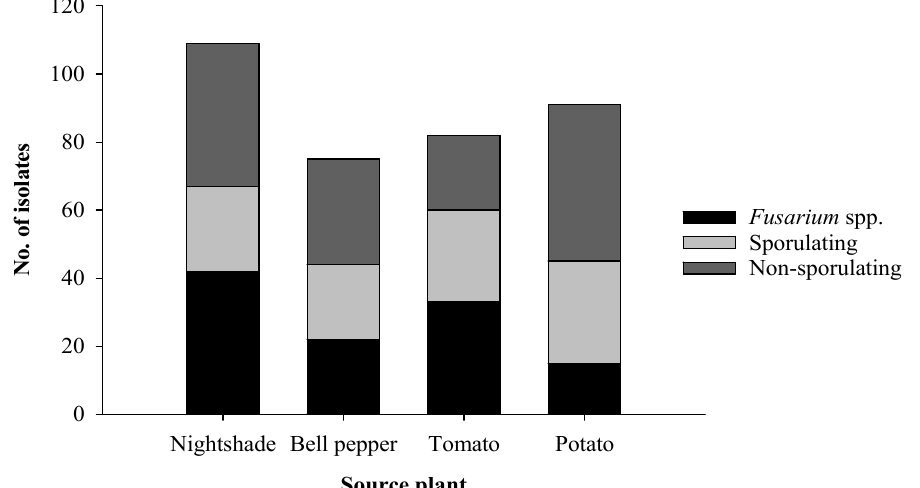
Figure 1. Distribution of the total fungal root endophytes found in four solanaceous host plants and classified into three categories: fusarial, sporulating, and non-sporulating endophytes.